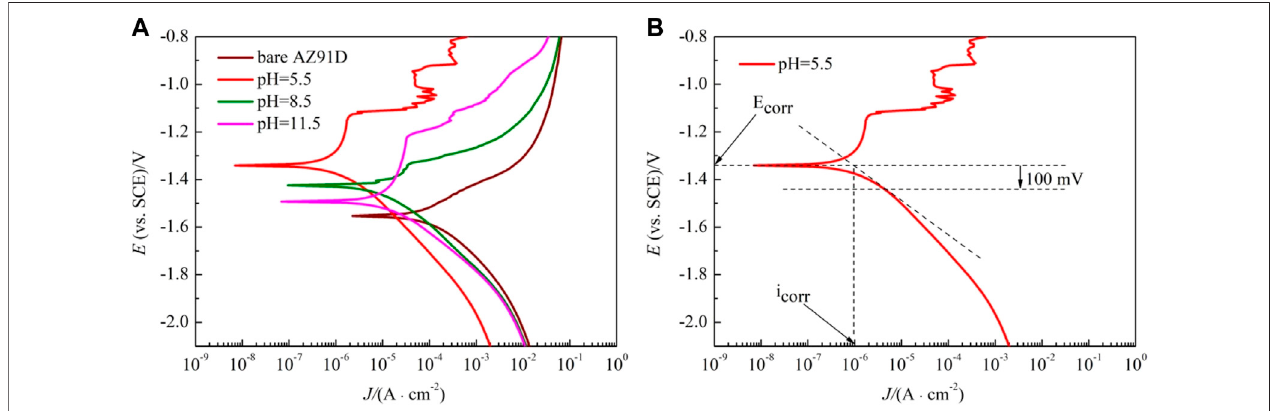
FIGURE 6 | Polarization curves of bare AZ91D and pH – treated samples in SBF: (A) polarization curves, (B) diagram of curve fi tting.